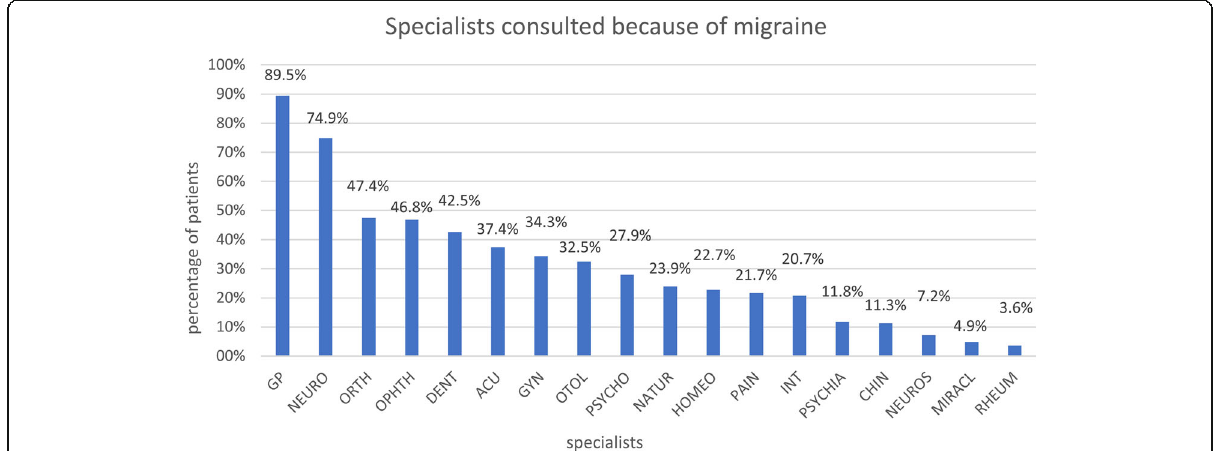
Fig. 1 Specialists which were consulted by patients because of their migraine (GP: general practitioner; NEURO: neurologist; ORTH: orthopedist, OPHTH: ophthalmologist, DENT: dentist, ACU: acupuncture specialist, GYN: gynecologist, OTOL: otolaryngologist, PSYCHO: psychologist, NATUR: natural medicine, HOMEO: homeopath, PAIN: pain specialist, INT: internist, PSYCHIA: psychiatrist, CHIN: traditional Chinese medicine specialist, NEUROS: neurosurgeon, MIRACL: faith healer, RHEUM: rheumatologist (multiple answers possible). (n =